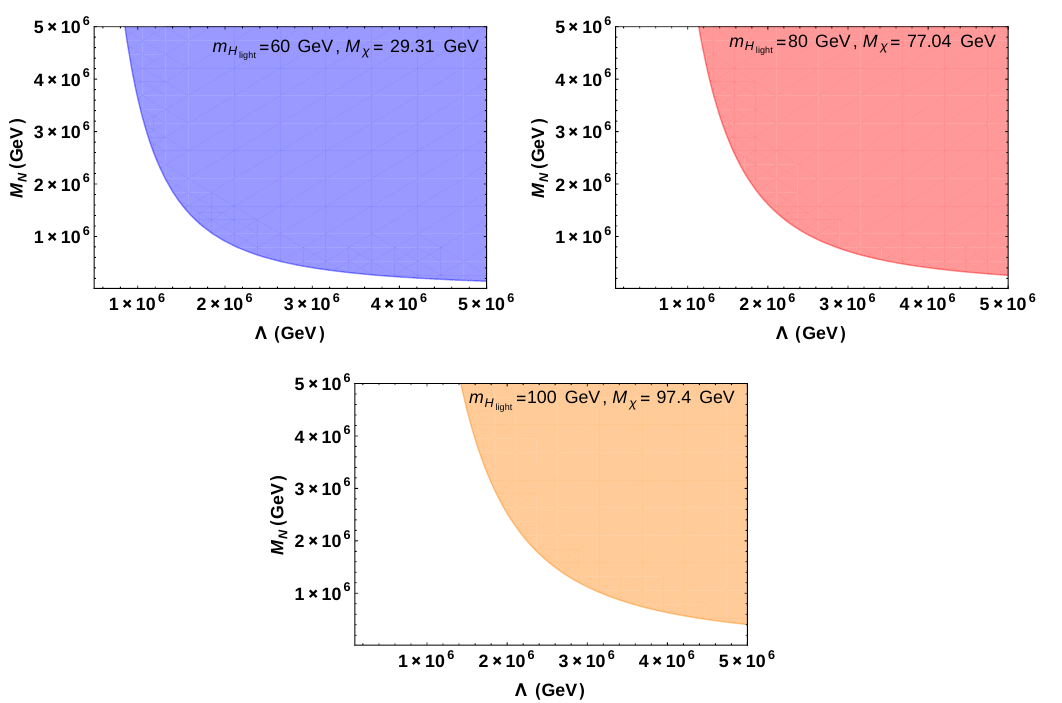
Figure 11 . Correlation between right handed neutrino mass M N and cut-o(cid:11) scale (cid:3) for m H = 60, 80 and 100 GeV with corresponding DM masses M (cid:31) =29.31, 77.04 and 97.4 GeV respectively satisfying both relic density and direct search